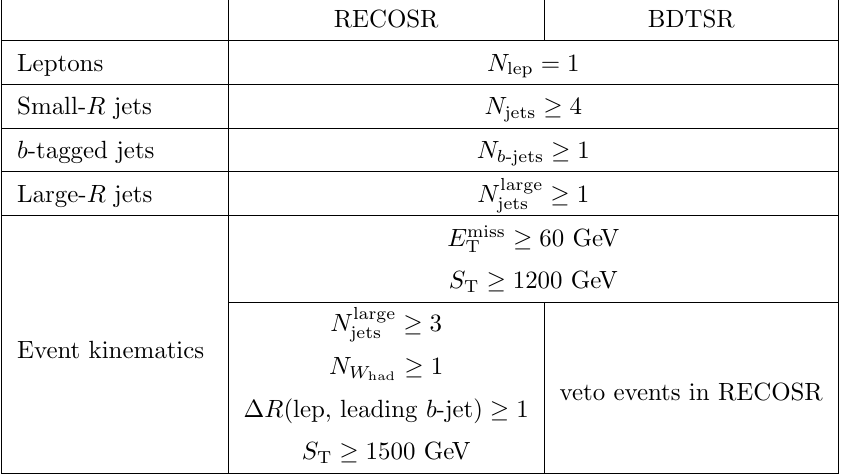
Table 1 . Summary of the event selection requirements of the two signal